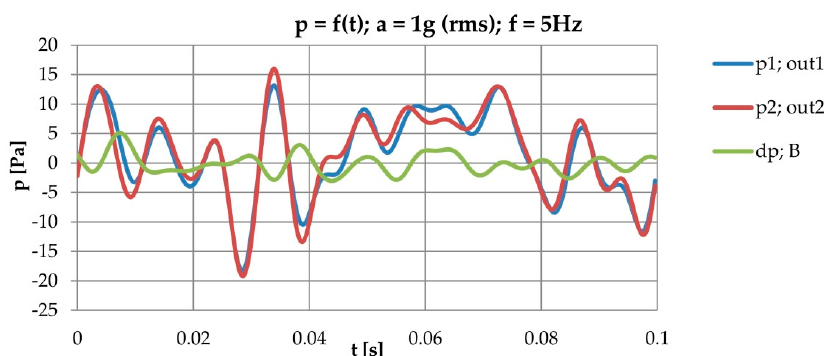
between p1-p2, a-the input.